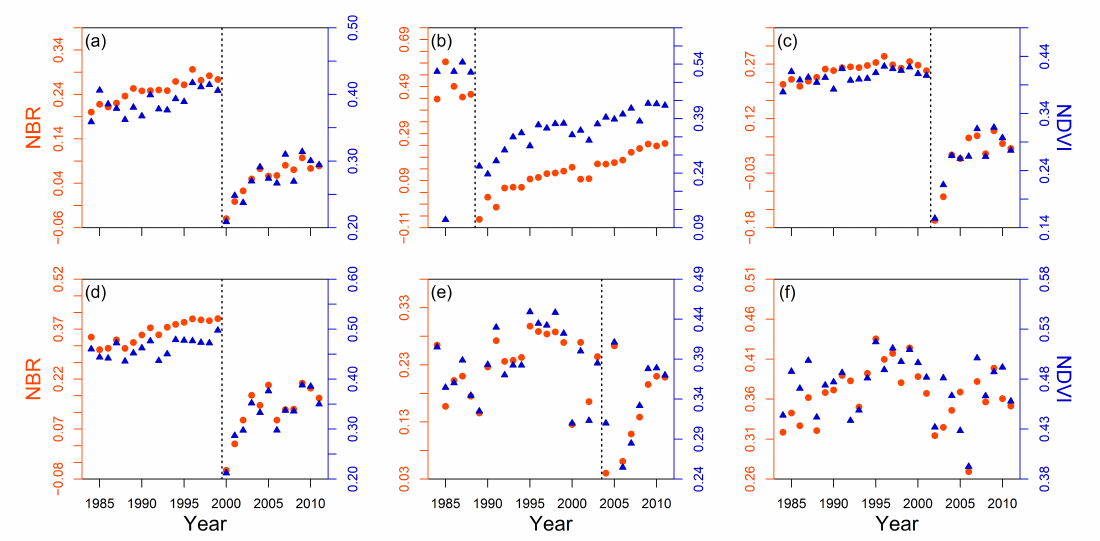
Figure A2. Normalized Burn Ratio ( NBR ) on left axis in red and Normalized Difference Vegetation Index ( NDVI ) on right axis in blue for five fires ( a – e ) that occurred at different locations in the region of interest between the period 1984–2011, with different severities and sizes ranging from mostly low to mostly high burn severity and from 5.9 to 523.7 km 2 . The vertical dotted line represents the occurrence date of each fire. A control area is also included ( f ) corresponding to an area with no fires during the period depicted in the abscissa. See Figure A3 for fire